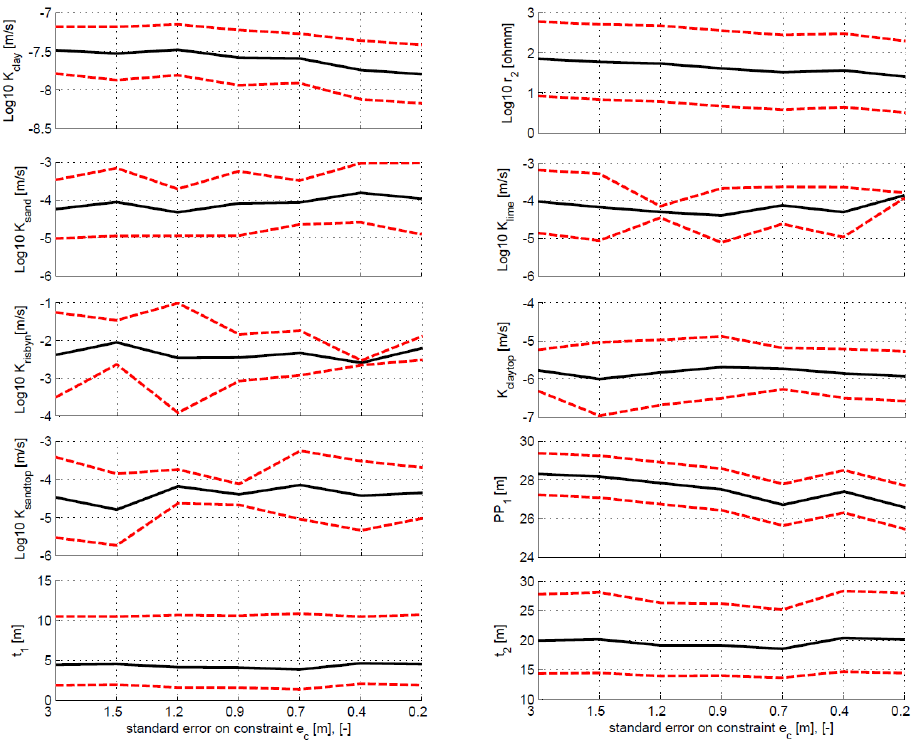
Fig. 10 Parameter estimates (black straight line) and confidence bounds (red dashed lines) for different values of e c when performing a JHI using a petrophysical relationship between K clay , r 1 and r 2 and a geometrical constraint between parameters PP 1 and t 1 and t 2 . The confidence bounds represent the parameter estimate ± 2 standard deviations.